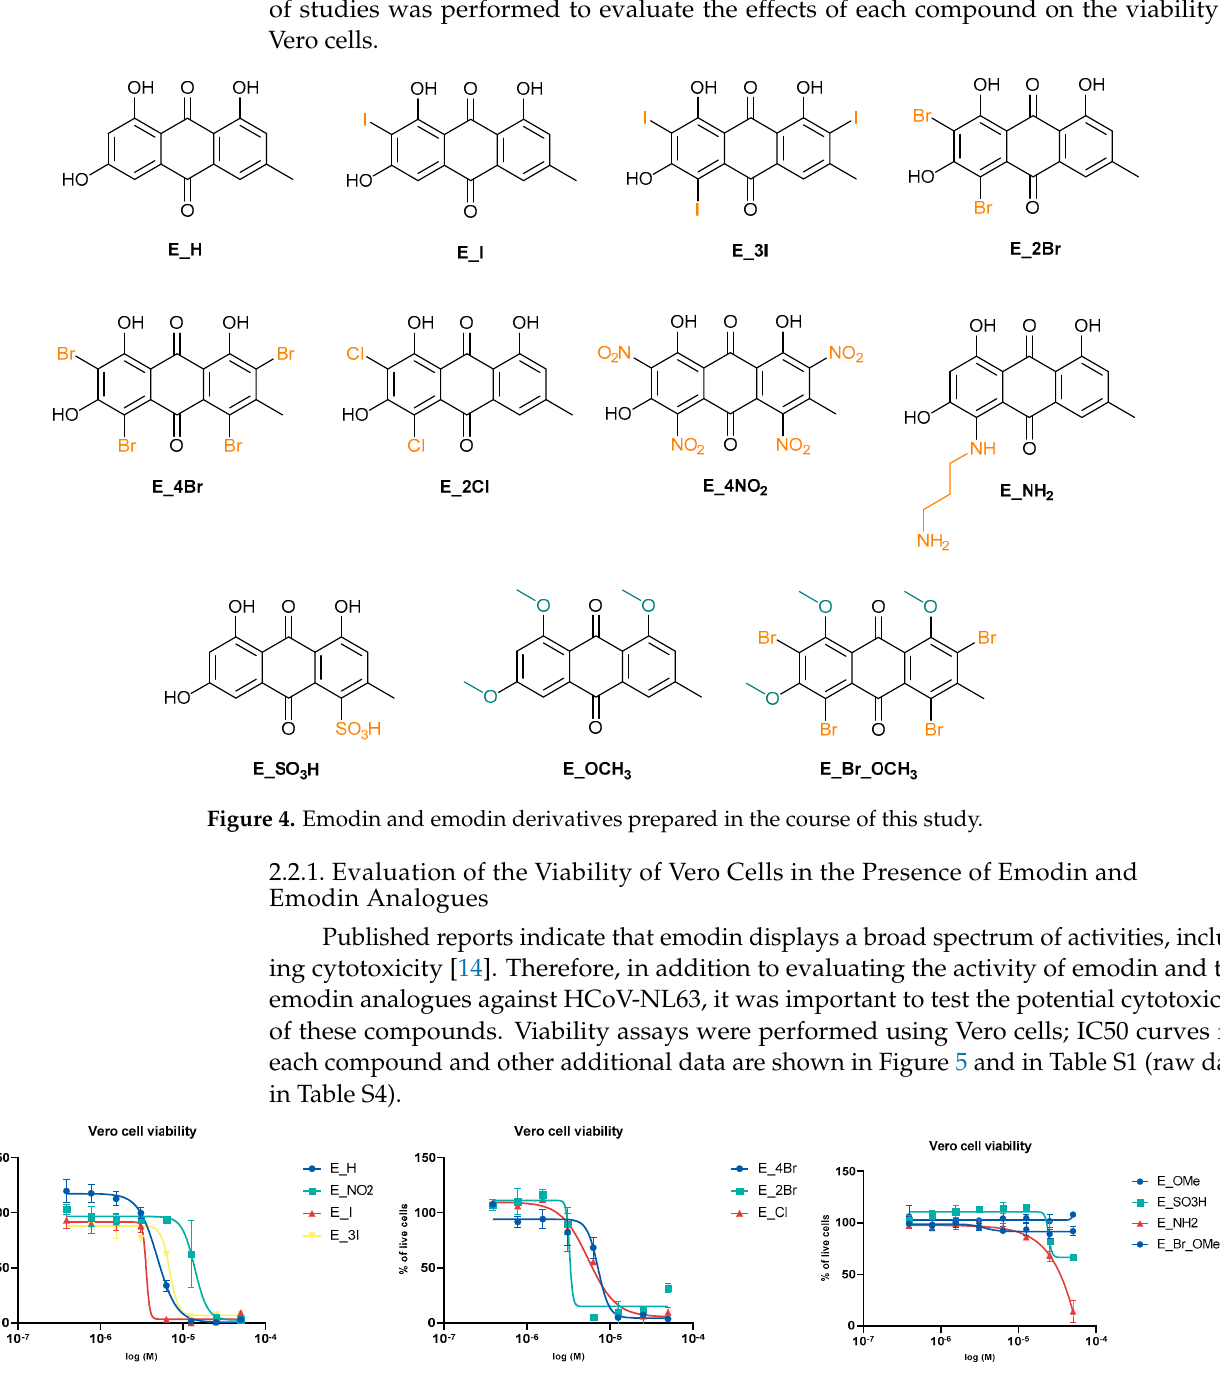
Figure 5. IC50 curves reflecting the effect of the tested compounds on Vero cell viability.